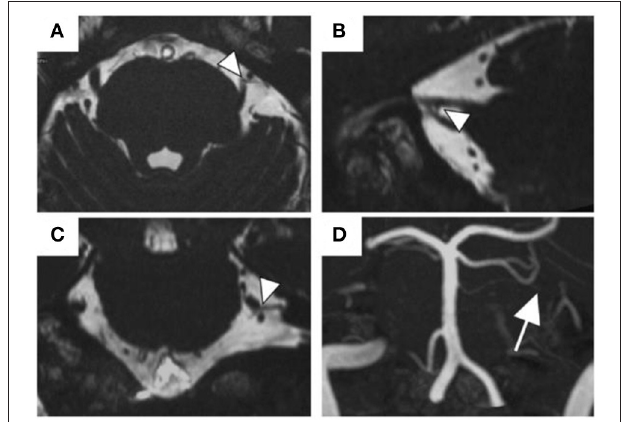
FIGURE 2 | The MR images of NVC of the trigeminal nerves. A 57-year old man with NVC of the trigeminal nerves (arrowheads). The superior cerebellar artery was the responsible blood vessel (arrow). (A) Transverse view of the 3D-CISS image, (B) sagittal view, (C) coronal view, (D) MIP display of 3D-TOF MRA. Abbreviations: MR, magnetic resonance; NVC, neurovascular contact; 3D-CISS, 3D constructive interference in steady-stat; MIP, maximum intensity projection; 3D-TOF MRA, 3D time-of-flight magnetic resonance